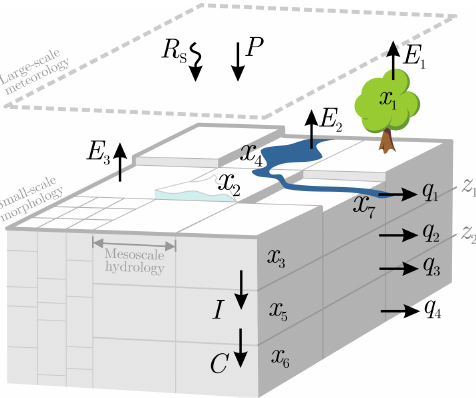
Figure 1. The concept of the mesoscale hydrologic model,